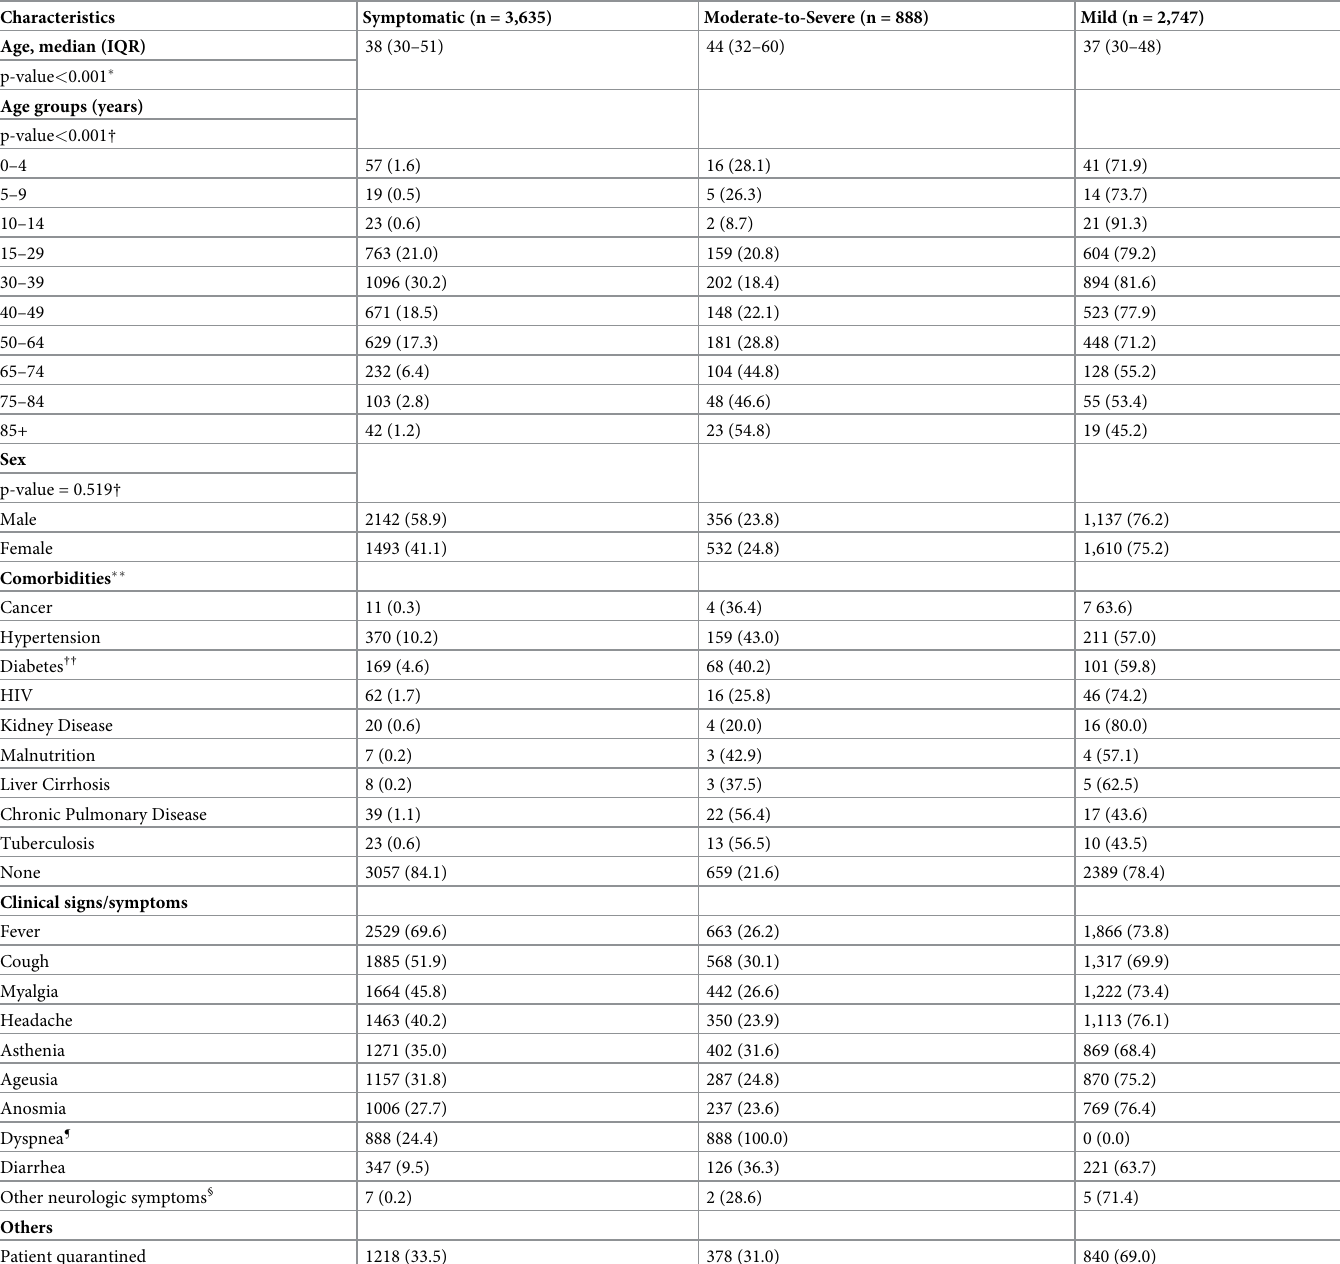
Table 2. Characteristics of symptomatic COVID-19 cases by disease severity.